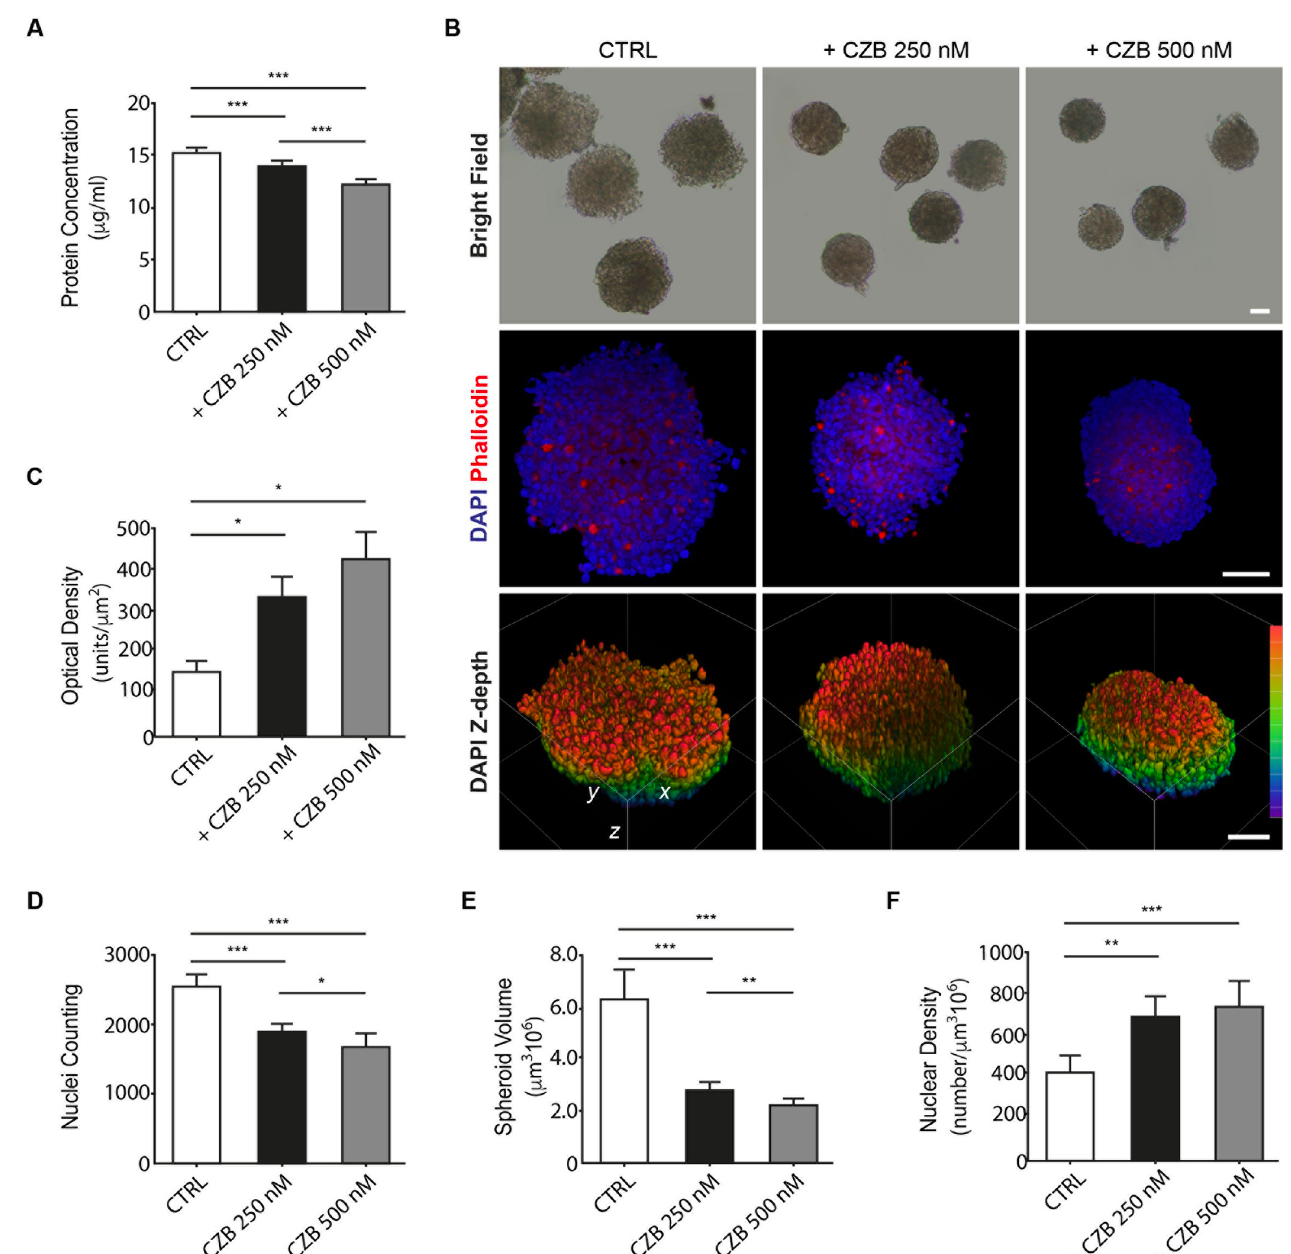
Fig 3. Protein quantification and imaging analysis of CZB treated LoVo spheroids. A) Protein quantification performed by NanoOrange assay of CZB 250 nM and 500 nM, and relative control. Data are presented as mean ± SD. Statistical analysis was performed using two-tailed unpaired Student’s t- test. � p < 0.05, �� p < 0.01, and ��� p < 0.001. B) Representative images of LoVo spheroids exposure to different doses of CZB after clearing procedures. The upper panel shows bright field imaging from control and treated spheroids at low magnification. The middle panel exhibits confocal imaging of DAPI (in blue) and phalloidin (in red) staining for nuclei and actin respectively. The lower panel provides volume view of DAPI signal in 3D z-depth confocal rendering reported as a scale of colors (palette on the right). Scale bars 50 μ m. C) Optical density of fixed LoVo spheroids, calculated as ratio between the mode of absorbance (subtracted to the background) and the spheroid area after 10 days of treatment with CZB 250 nM (histogram in black), 500 nM (histogram in gray) and relative control (histogram in white). Statistical analysis was performed using two-tailed unpaired Student’s t-test. � p < 0.05, �� p < 0.01, and ��� p < 0.001. D) Total cell nuclei counting of fixed LoVo spheroids after 10 days of treatment with CZB 250 nM (histogram in black), 500 nM (histogram in gray) and relative control (histogram in white). Statistical analysis was performed using two-tailed unpaired Student’s t- test. � p < 0.05, �� p < 0.01, and ��� p < 0.001. E) Volume of fixed LoVo spheroids after 10 days of treatment with CZB 250 nM (histogram in black), 500 nM (histogram in gray) and relative control (histogram in white). Statistical analysis was performed using two-tailed unpaired Student’s t- test. � p < 0.05, �� p < 0.01, and ��� p < 0.001. F) Volumetric cell nuclei density of fixed LoVo spheroids, calculated as ratio between the total number of nuclei and the spheroid volume after 10 days of treatment with CZB 250 nM (histogram in